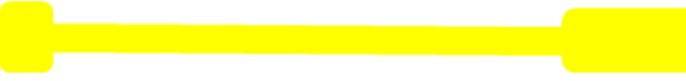
Figure 5. Schematic diagram of micro voltage sensor.